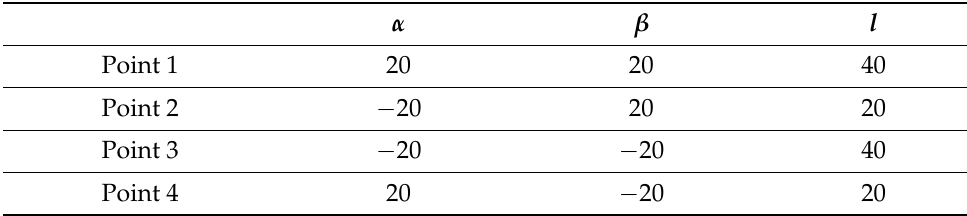
Table 3. Trajectory for experiment 3.